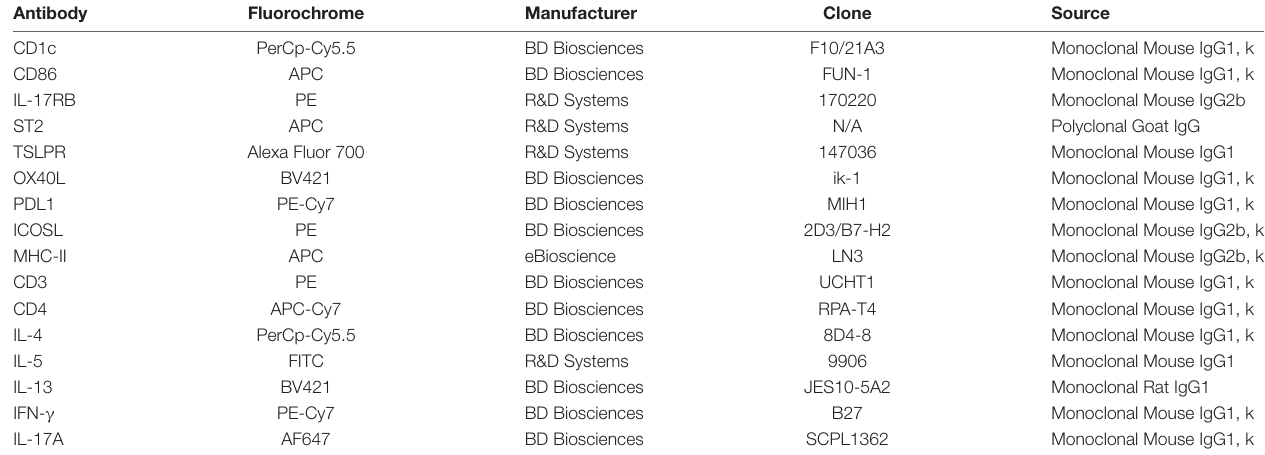
TABLE 2 | Antibodies used for flow cytometry. Antibody Fluorochrome Manufacturer